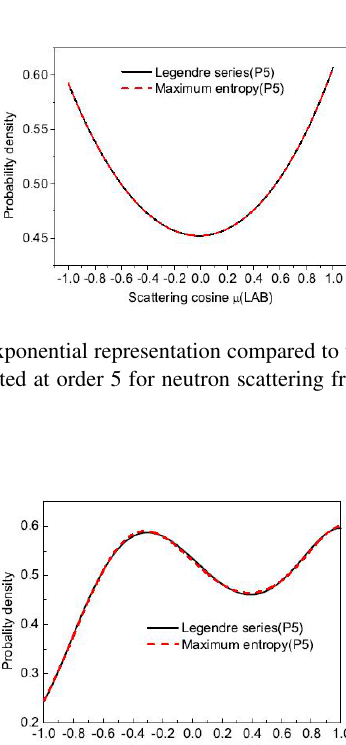
Figure 1. Procedure of generating multigroup XS Library in ACE fromat